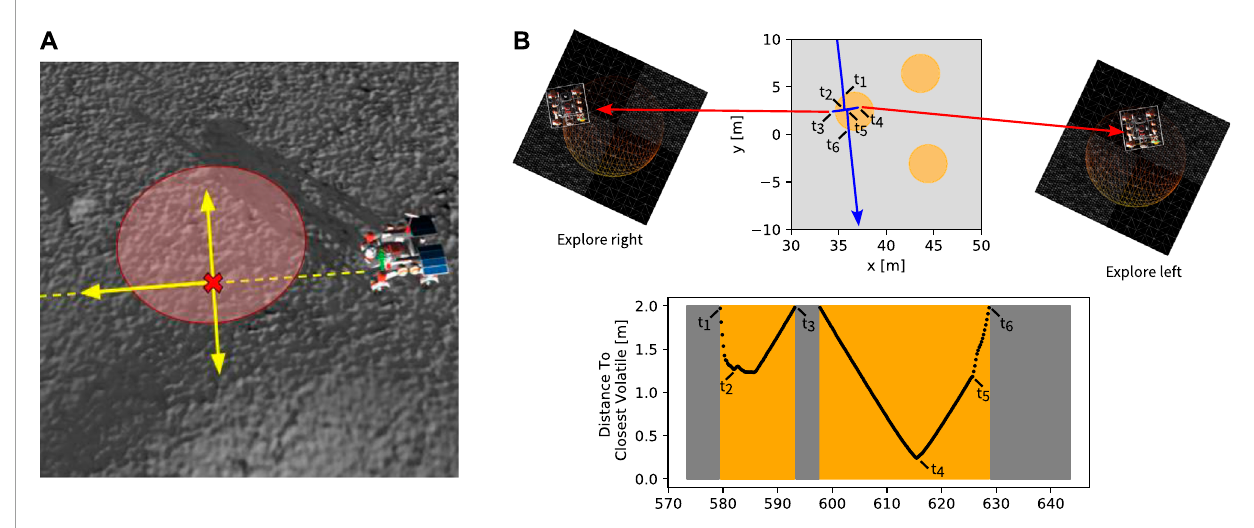
FIGURE 7 Honing Procedure. (A) Along its exploration trajectories (yellow dashed line), a Scout can find a volatile and will perform maneuvers to guess the position of the center of the resource. (B) The scout will decrease its speed and continue on its original trajectory while the sensed distance decreases (between timestamps t 1 and t 2 ). Once the distance increases ( t 2 ) , it expects the volatile to be to its left or right, orthogonally to the exploration trajectory. In sequence, it will move a few meters to the left ( t 3 ) and to the right ( t 4 ) to hone the reported volatile position. Once the sideways maneuvers end ( t 5 ) , the Scout resumes its exploration trajectory with and regular speed ( t 6 )